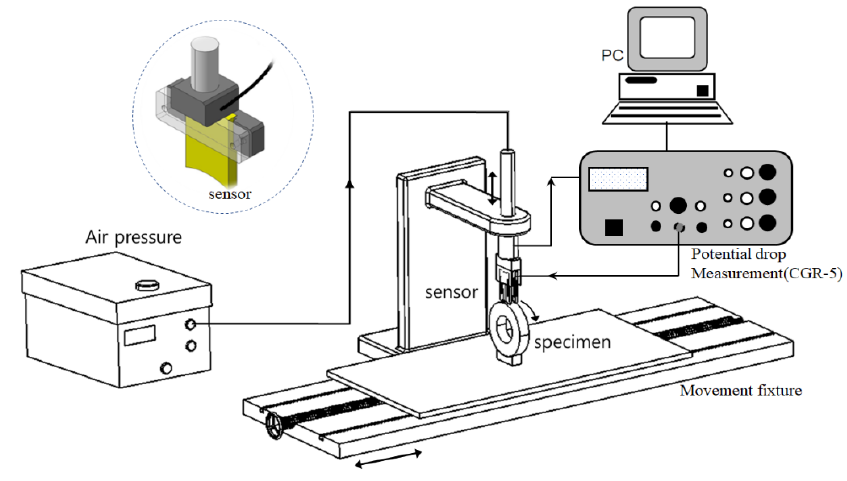
Figure 3. Measurement system.